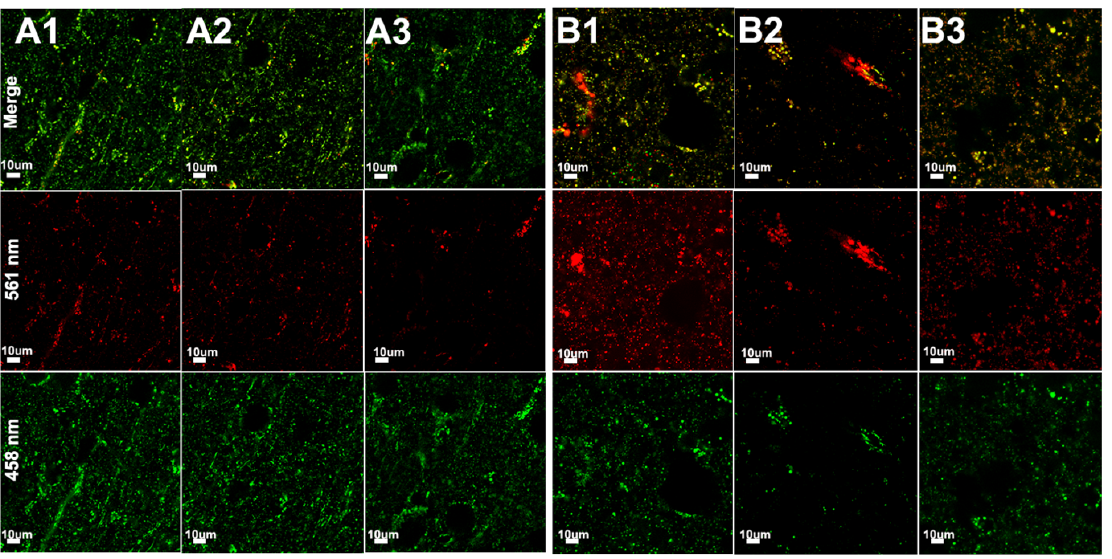
Figure 4. Assessment of mitophagy 8 h after HI in the brain tissue of mt-Keima mice by super resolution microscopy. ( A1 – A3 ): injured hemisphere ( B1 – B3 ) uninjured hemisphere; serial sections are visualized at 100 µ m intervals of both hemispheres.